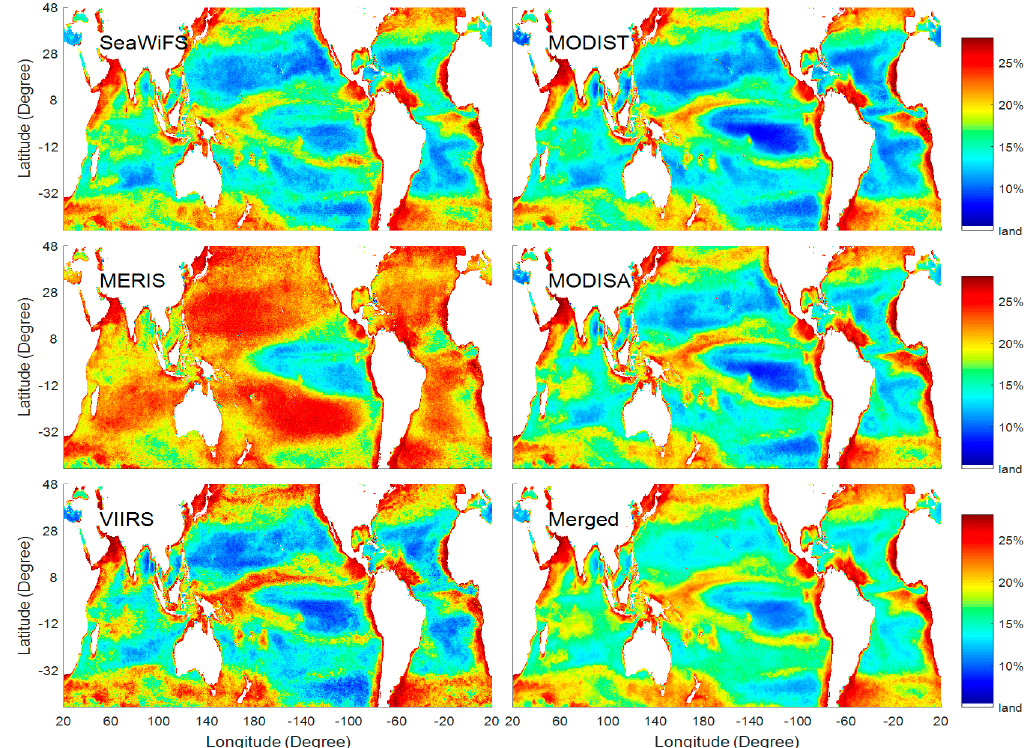
Figure 11. The MRD values of five satellites and the merged data computed on the “truth value” of the fitted values of Equation (3) with the same pixel and same day of year. The values of the pixels are indicated by color bar in the unit of percentage.